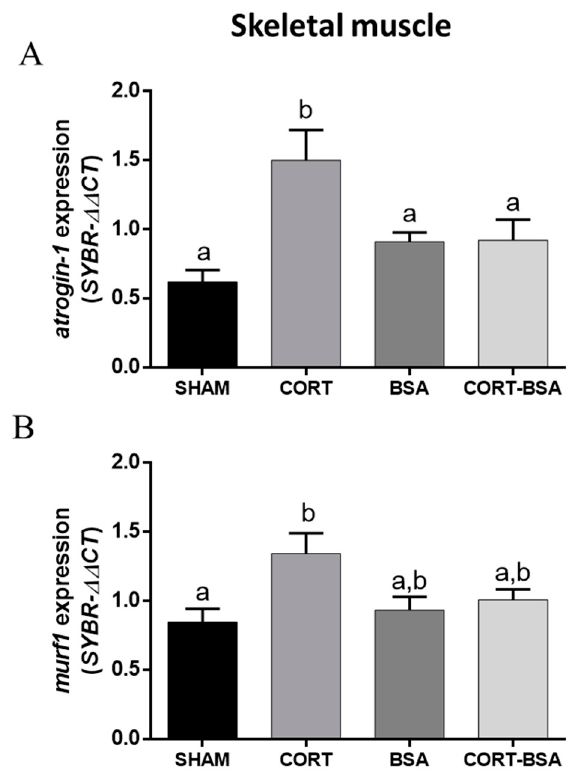
Figure 6. Skeletal muscle atrophy-related genes expression. Expression of atrogin-1 ( A ) and murf1 ( B ) were evaluated in vehicle (sham-control), cortisol, BSA and cortisol-BSA administered fish at 72 h post-treatment. Results are expressed as mean ± SEM ( n = 8). Different letters indicate significant differences between groups ( p value < 0.05). All data were analyzed using one-way ANOVA and Tukey’s HSD as a post-hoc test .